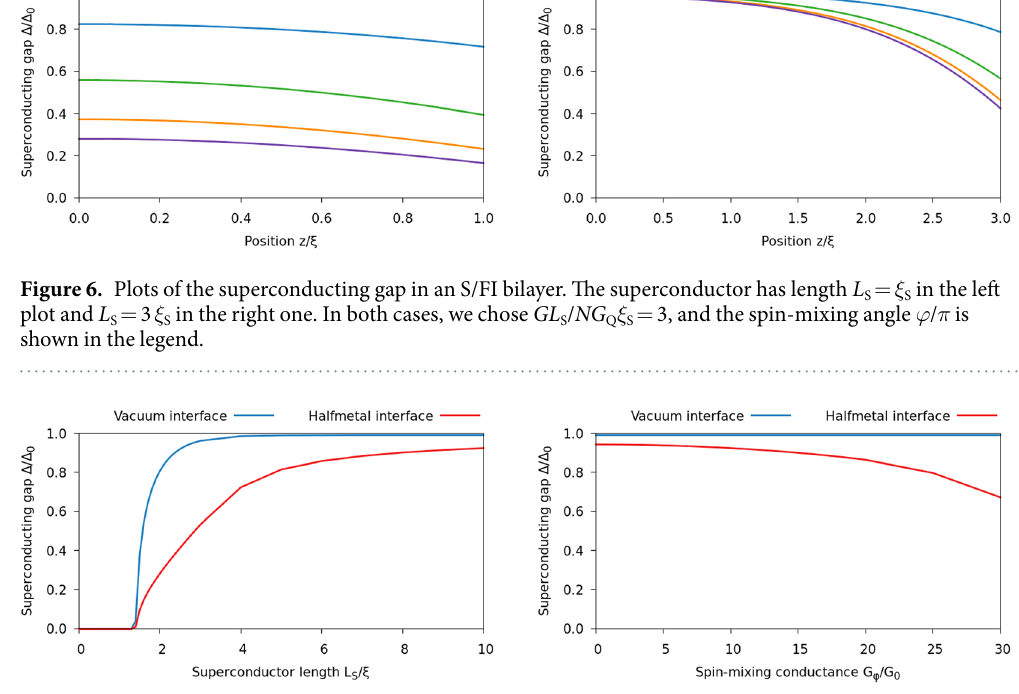
Figure 7. Plots of the superconducting gap at the interfaces of an S/HM bilayer. Both the plots are for a long halfmetal L H = 10 ξ S ; the difference is that we fix G ϕ / G 0 = 10 but vary L S in the left plot, while we fix L S = 10 ξ S and vary G ϕ in the